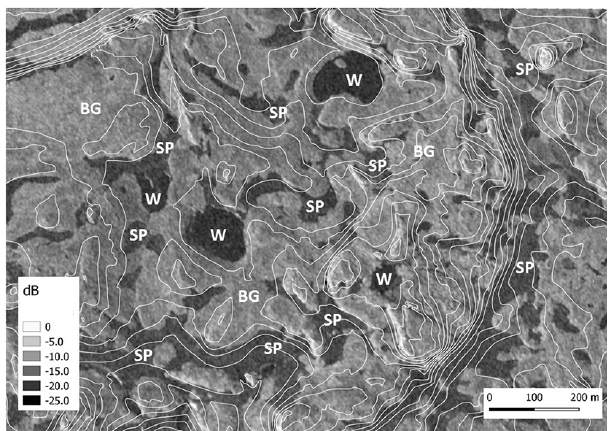
Figure 12. TerraSAR-X SpotLight mode HH polarization backscat- tering (sigma-nought) scene from 12 January 2012 with examples of visual interpretation of bare ground (BG), water (W) and snow patches (SP). Contour lines at 5m